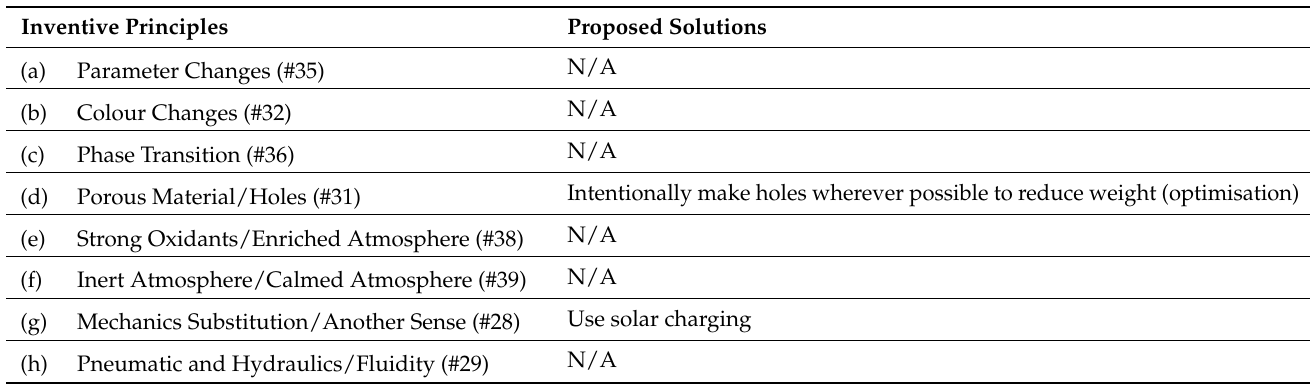
Table 10. Inventive principles for separation by condition and the proposed